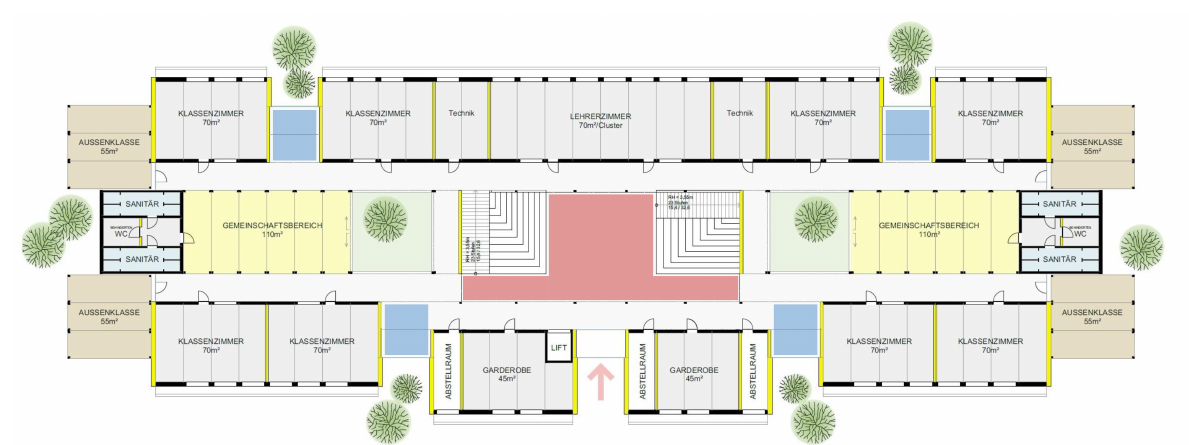
Figure 7. Floor Plan: Compulsory school [12].